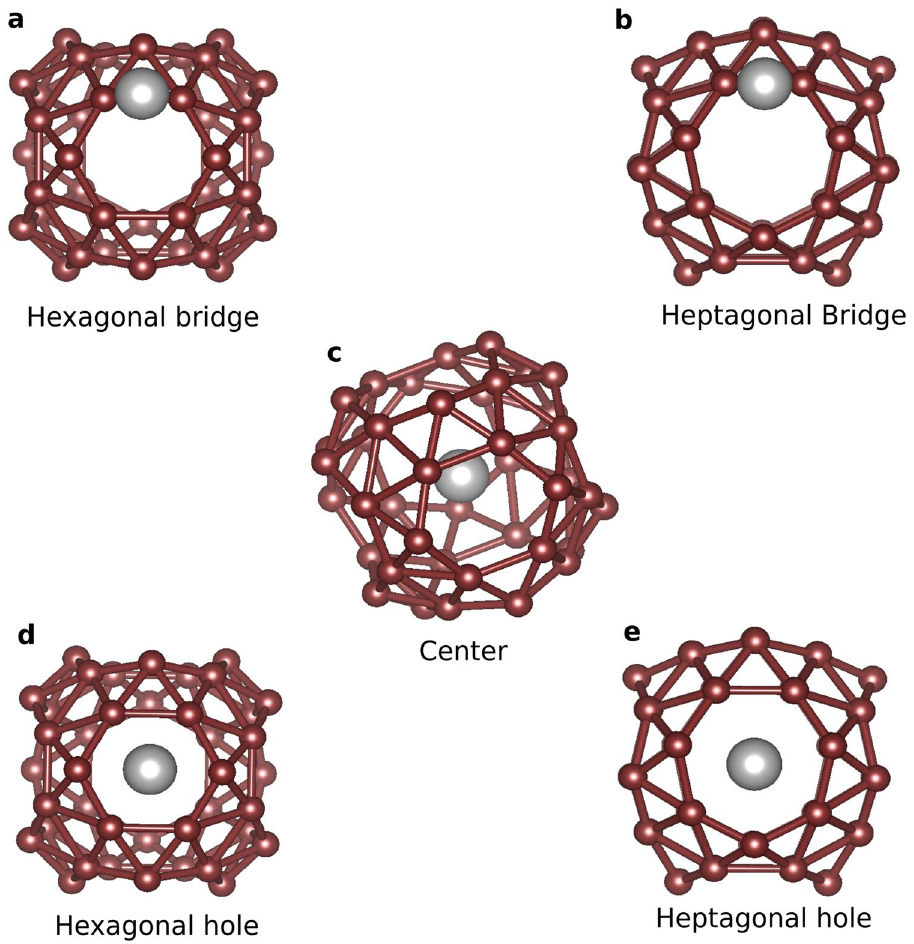
Figure 1. The adsorbate atom, represented by grey ball, can be placed on five different positions in the borospherene (B 40 ) represented by brown balls. The five different sites are ( a ) on the B-B bond of the hexagonal ring, ( b ) on the B-B bond of the heptagonal ring, ( c ) center of the cage, ( d ) hexagonal hole and ( e ) heptagonal